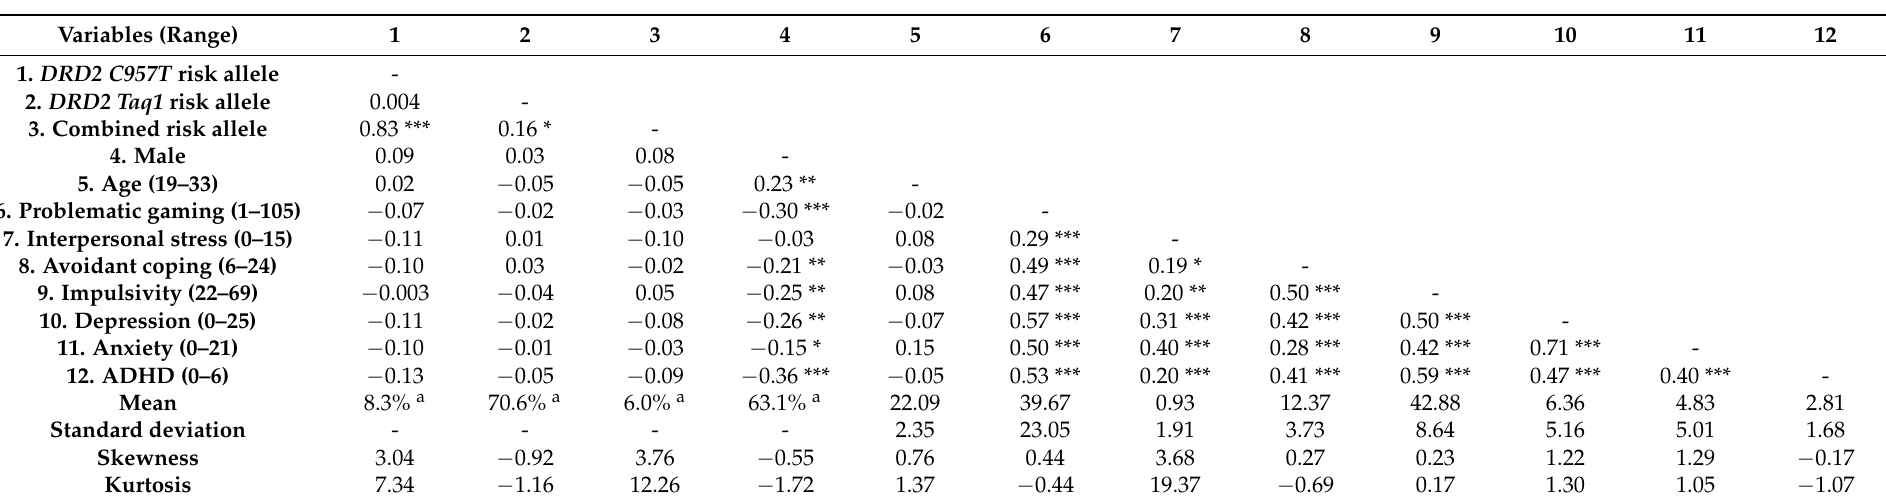
Table 1. Means, standard deviations, and correlation of study